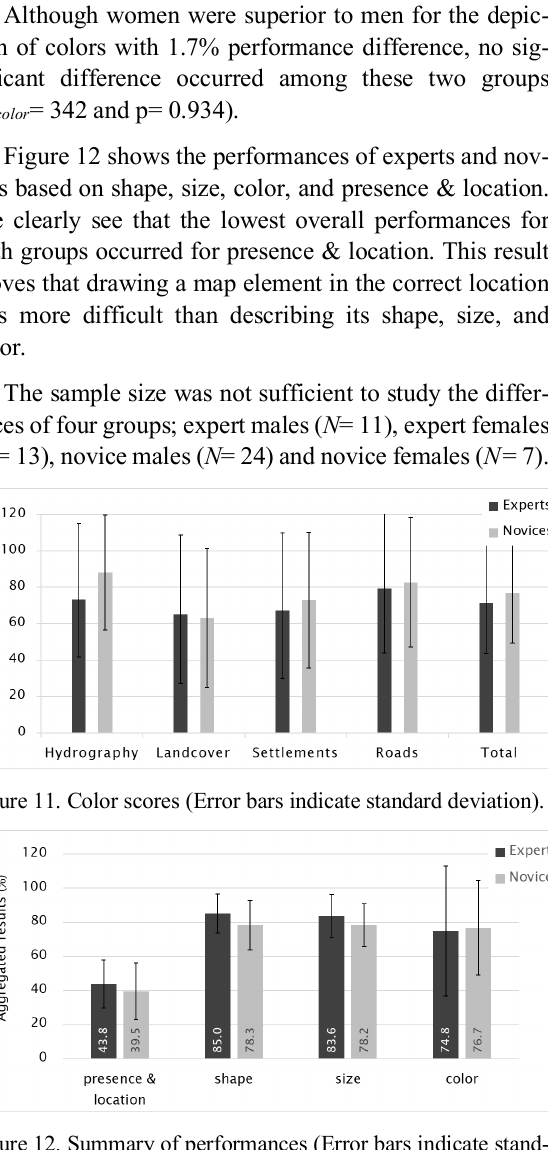
Figure 12. Summary of performances (Error bars indicate stand- ard